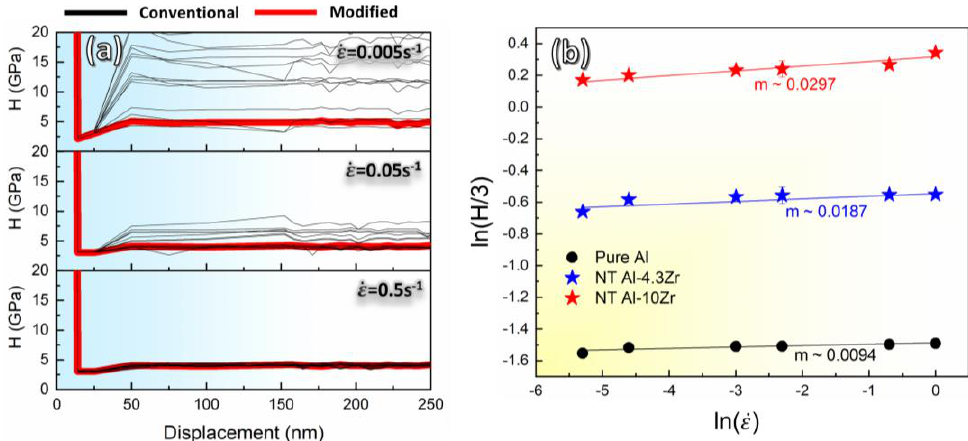
Figure 4. ( a ) Comparisons of hardness vs. displacement plots for the NT Al–10Zr specimen by using the conventional and modified nanoindentation method at various strain rates. ( b ) Comparison of constant strain rate nanoindentation results among Al, and NT Al–4.3Zr and Al–10Zr films revealing an increase in strain rate sensitivity ( m ) at higher Zr content.